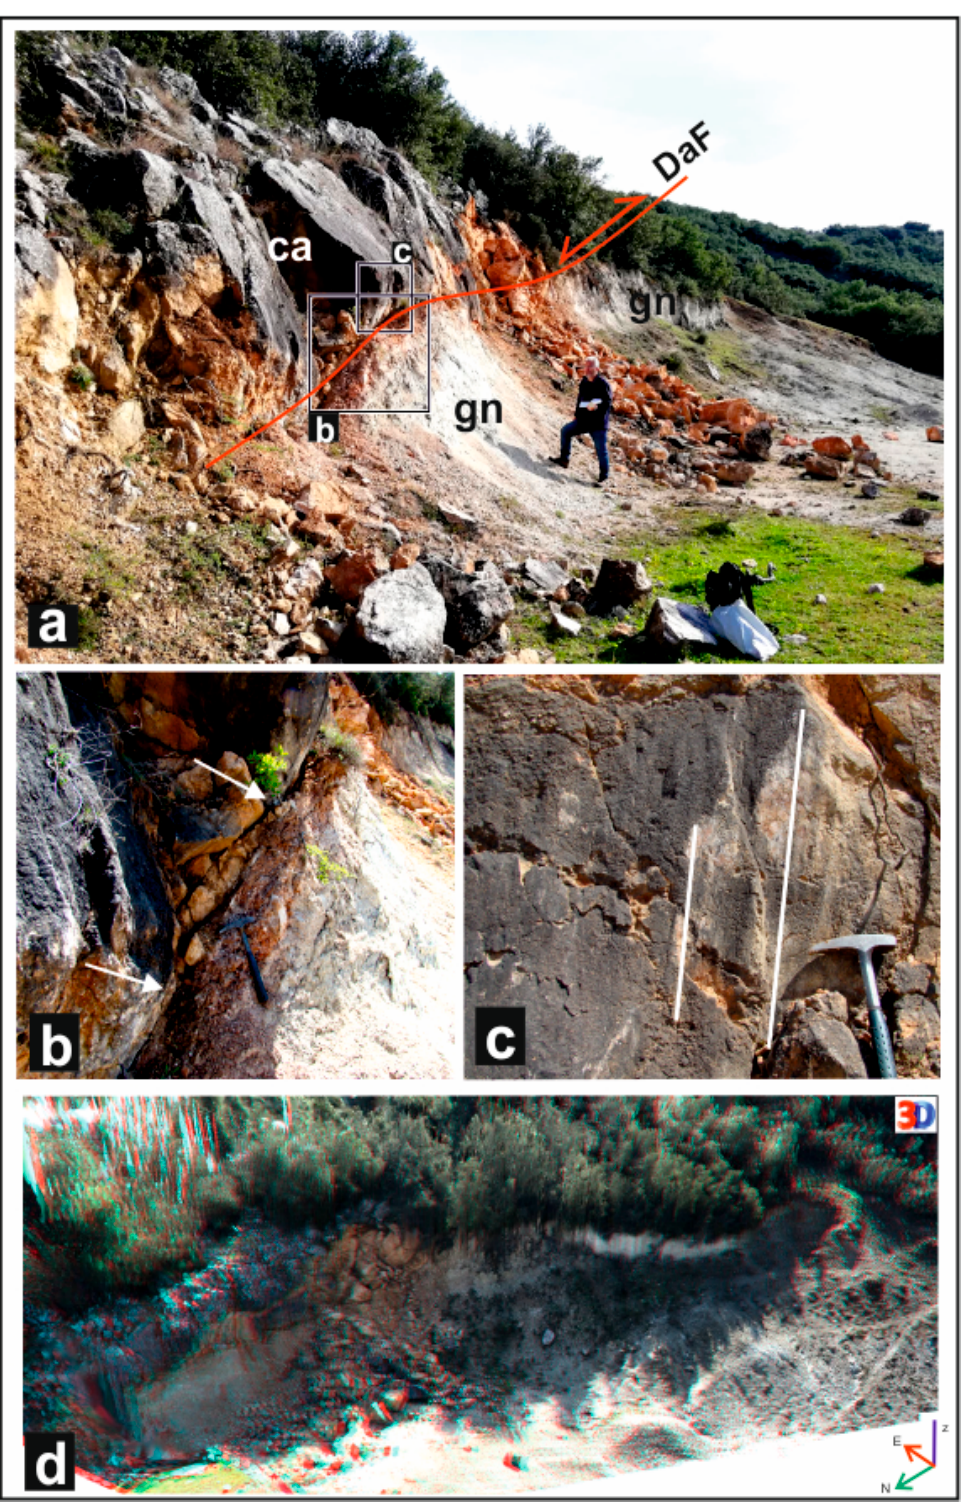
Figure 13. ( a ) View of DaF showing rockslides related with the fault outcrop and the two fault blocks. Photo is taken looking southeast. ( b ) Detail of rockslides developed during Damasi earthquake. Note that sliding site is crossed by a dense array of open cracks, most of which are trending NW. ( c ) Dip-slip slickenlines on carbonates along DaF zone. ( d ) Oblique 3D panoramic view of DaF and details of seismically induced rockfalls. Model is based on drone captures looking